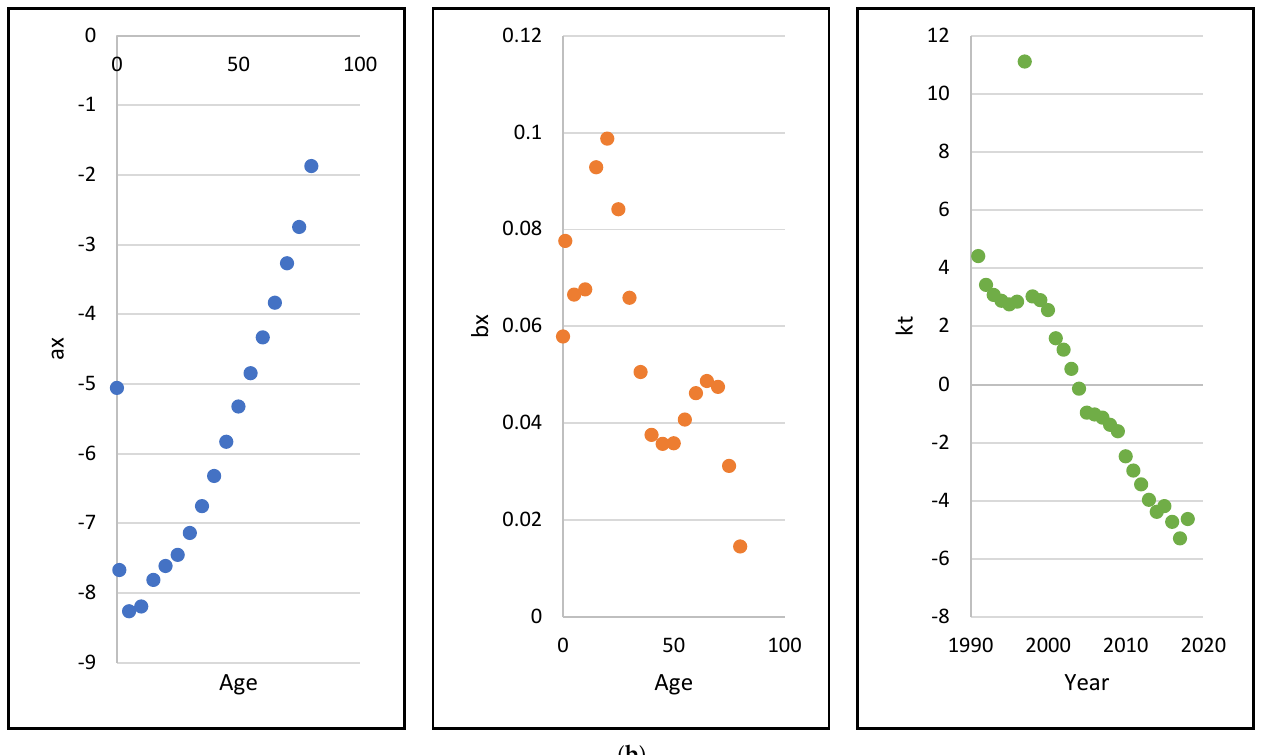
Figure 3. The Estimated Lee–Carter Parameters for ( a ) Malaysian Males and ( b ) Malaysian Females.